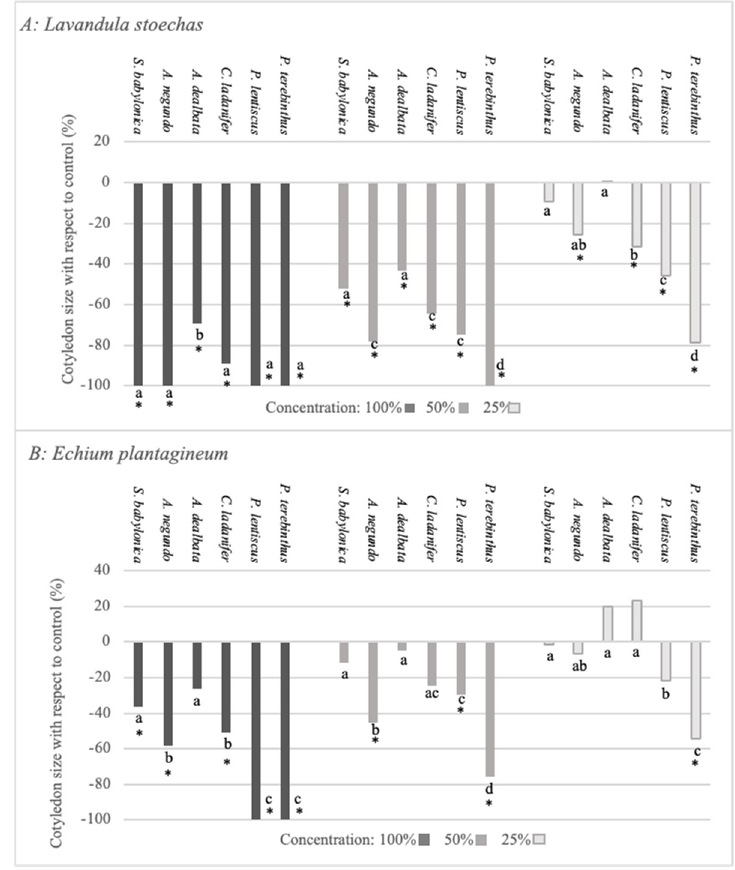
Figure 5. Effect of S. babylonica, A. negundo, A. dealbata, C. ladanifer, P. lentiscus, and P. terebinthus extract on cotyledon size of L. stoechas ( A ) and E. plantagineum ( B ) at 100%, 50%, and 25% concentrations; a, b, c, d: lowercase letters indicate significant differences between species on the same concentration (Mann-Whitney test, p < 0.05). *: Significant difference of control (Mann-Whitney test, p < 0.05). Table 2. Percentage on germination, root size, cotyledon emergence, and cotyledon size according to the group of species and extract concentration in E. plantagineum and L. stoechas . The values are the mean of the species that constituted the native group and the non-native group as an activity function with respect to the control (negative values mean inhibition; positive values mean stimulation).